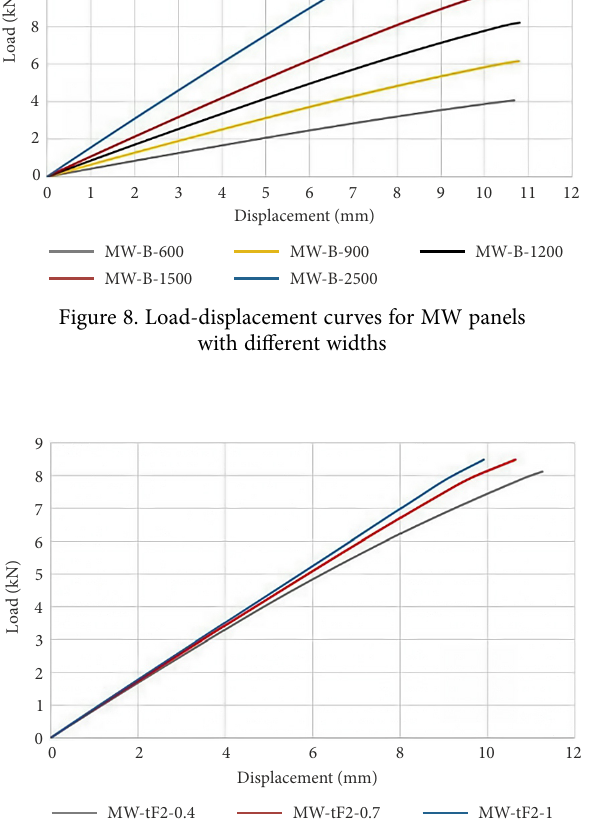
Figure 10. Load-displacement curves for MW panels with different thickness of internal